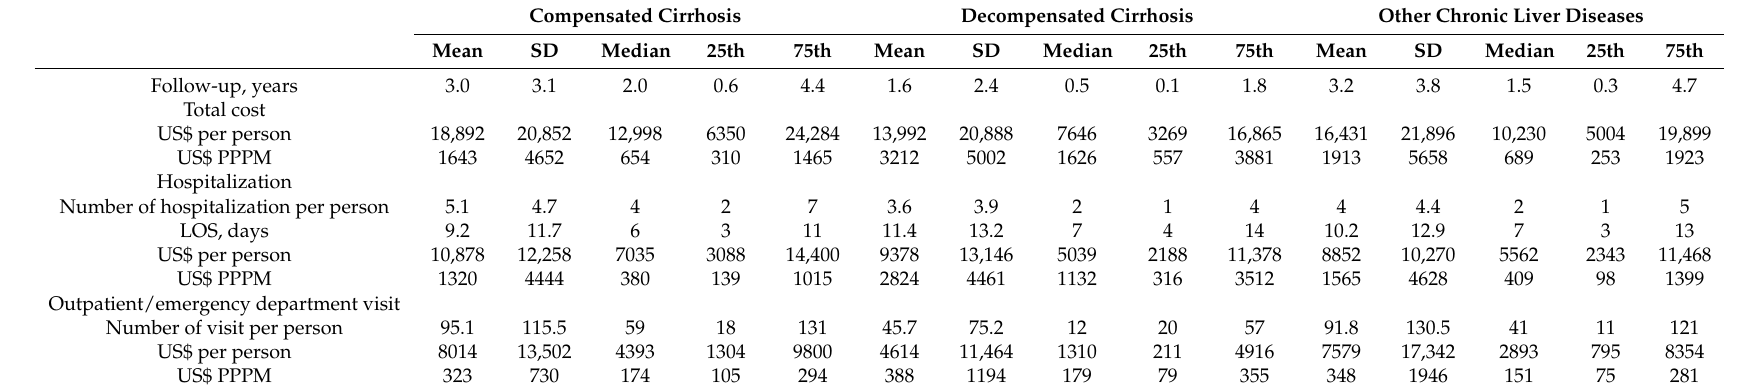
Table 4. Heath service use and costs among HCC patients, by disease